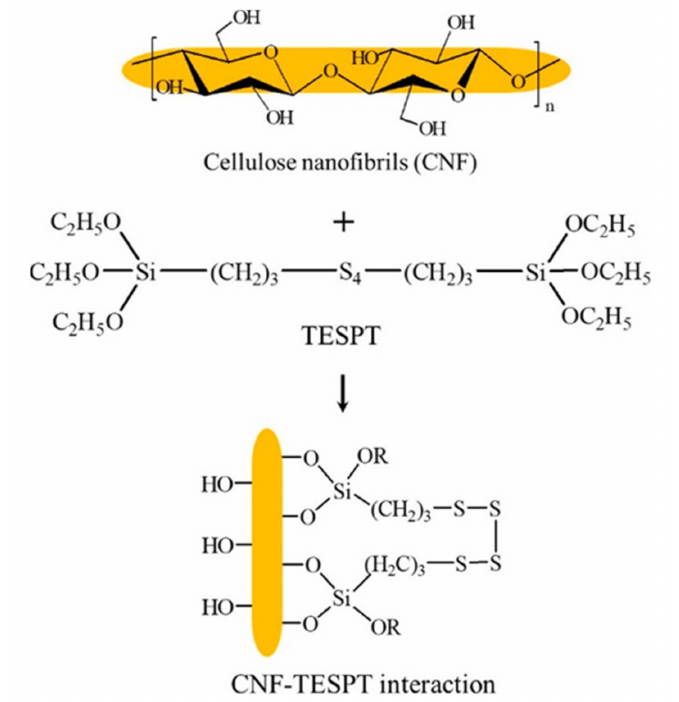
Figure 7. Proposed mechanism of interaction between CNF and TESPT (Somseemee et al. [55]; with permission from Elsevier Science Ltd., Amsterdam,